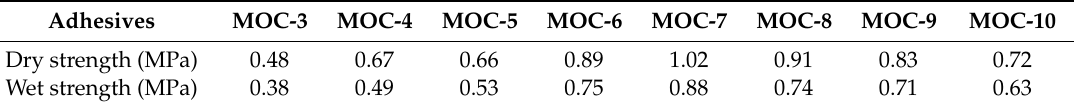
Table 5. Wet shear strength of the wood adhesives reported in the literature [3,11,29,38,39].